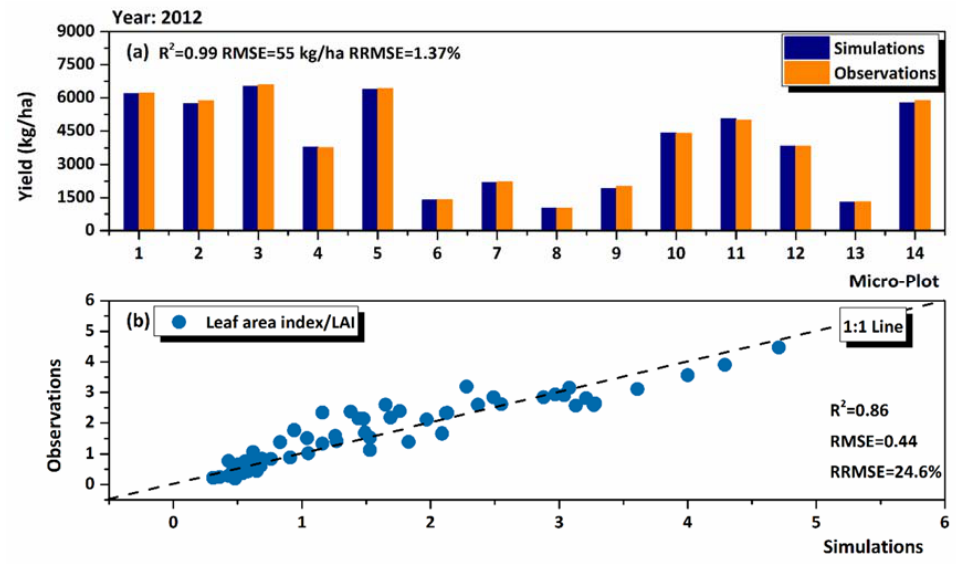
Figure 4. WOFOST ‐ ES model ‐ simulated and observed yield ( a ) and leaf area index (LAI, b ) in 2012. Figure 4. WOFOST-ES model-simulated and observed yield ( a ) and leaf area index (LAI, b ) in